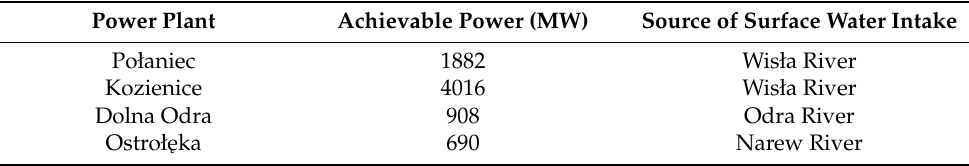
Table 1. Power plants with an open cooling